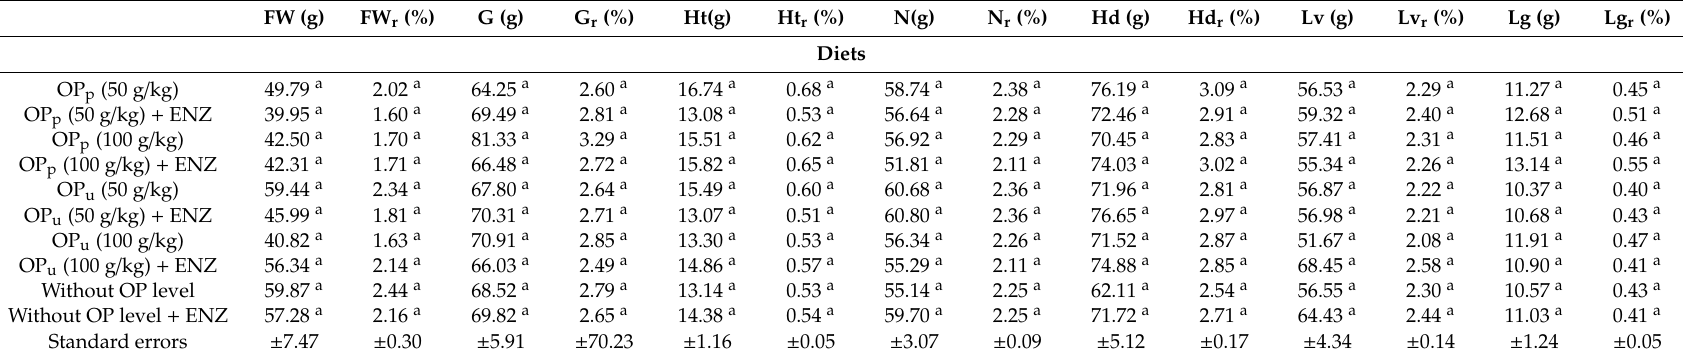
Table 5. O ff al traits of broilers fed diets containing di ff erent amounts of processed (OP p ) and unprocessed (OP u ) olive pulp, with and without enzymes (ENZ), in the period 1–6 weeks of